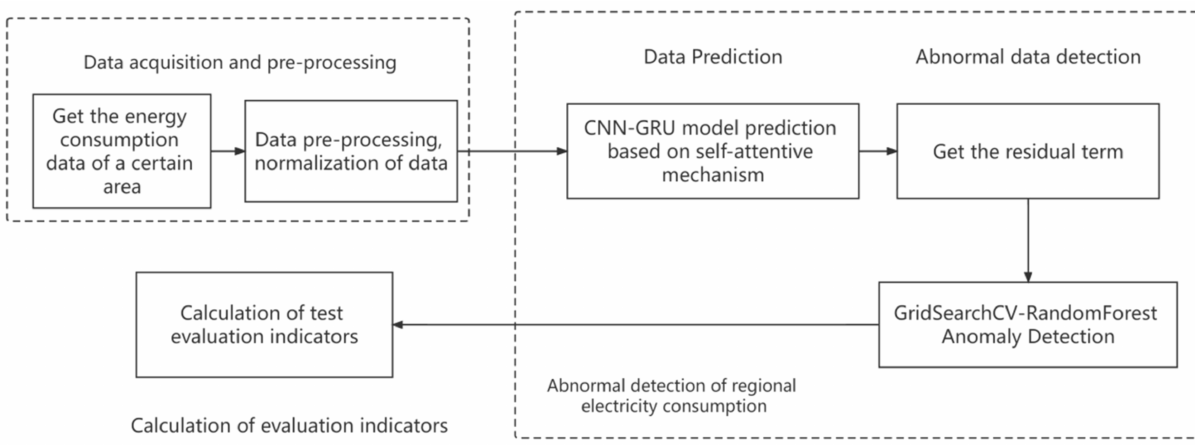
Figure 1. CGA-RF abnormal data detection flow